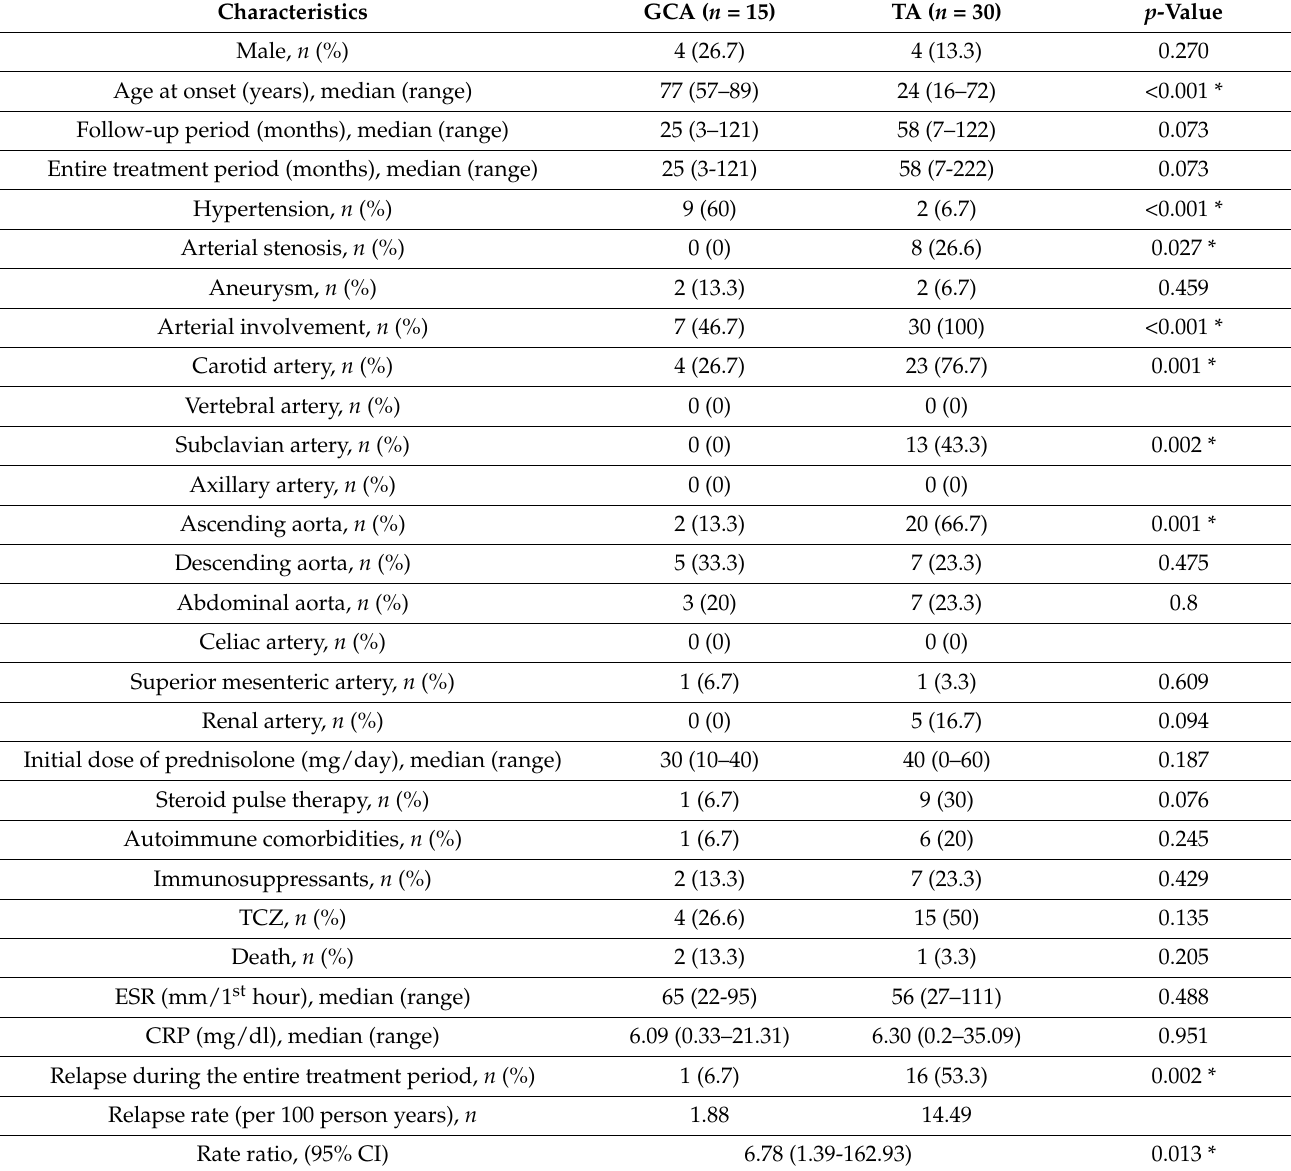
Table 1. Comparisons of clinical features between patients with GCA and those with TA.